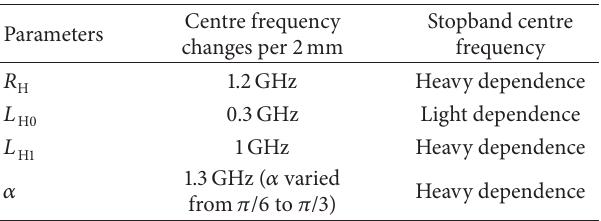
Table 2: The effects of Arc H-shaped slot parametric variation on stopband centre